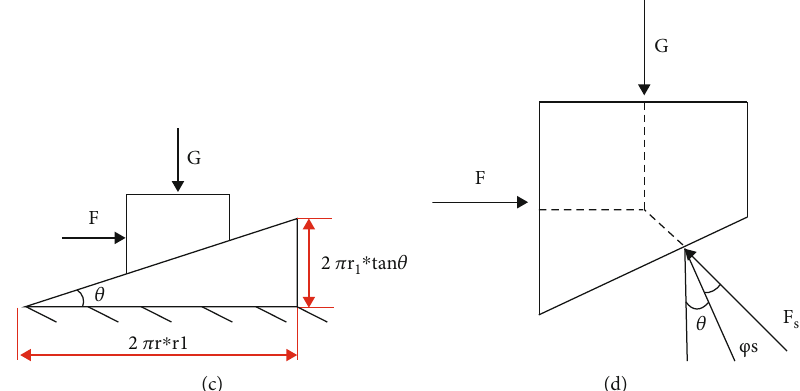
Figure 3: (a) Overall thread structure diagram. (b) Partial thread structure stress analysis. (c, d) Thread section stress analysis diagram.